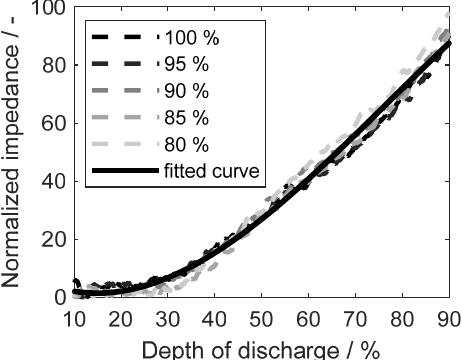
Figure 10. Normalized 1 Hz impedance vs. DoD.